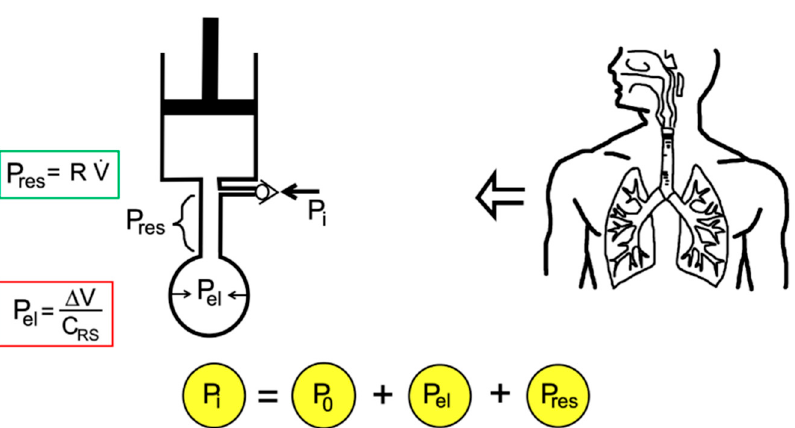
Figure 1. Mono ‐ compartment model of the respiratory system connected to ventilator using me ‐ chanical